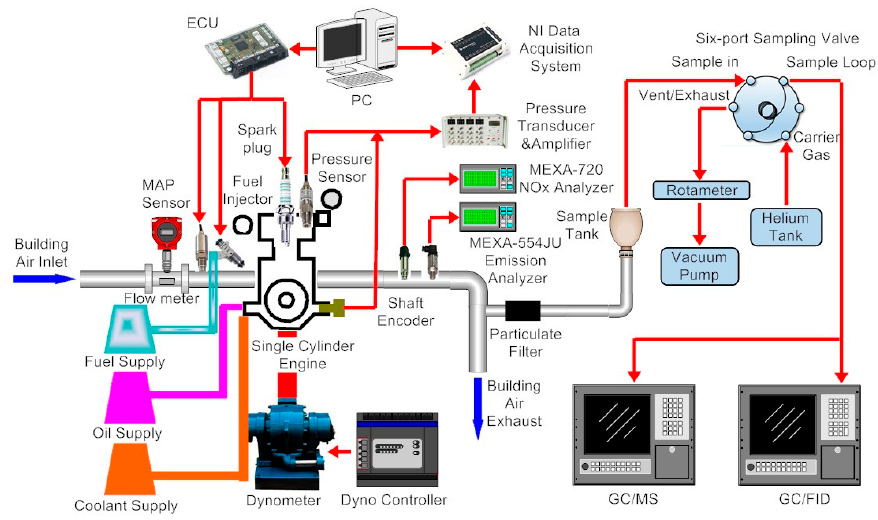
Figure 1. Schematic of the engine test bench.